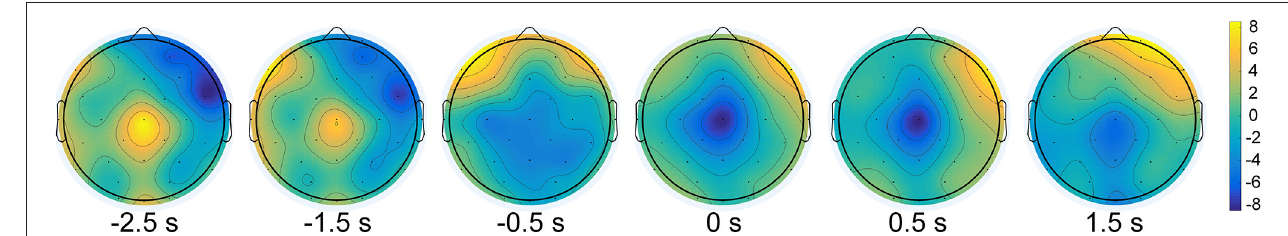
FIGURE 2 | Topographic representations of the brain activity at different time points from − 2.5 s to 1.5 s with respect to the actual movement onset.